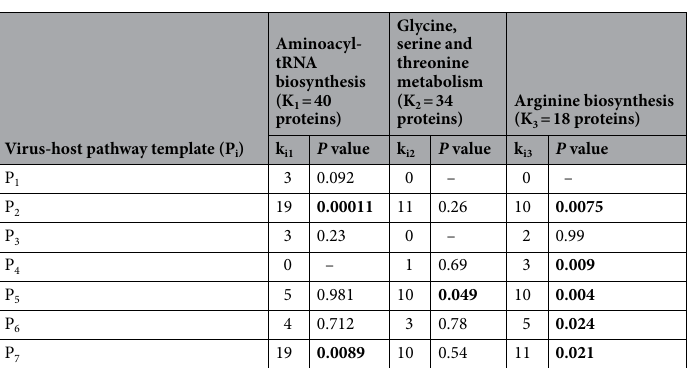
Virus-host pathway template (P i